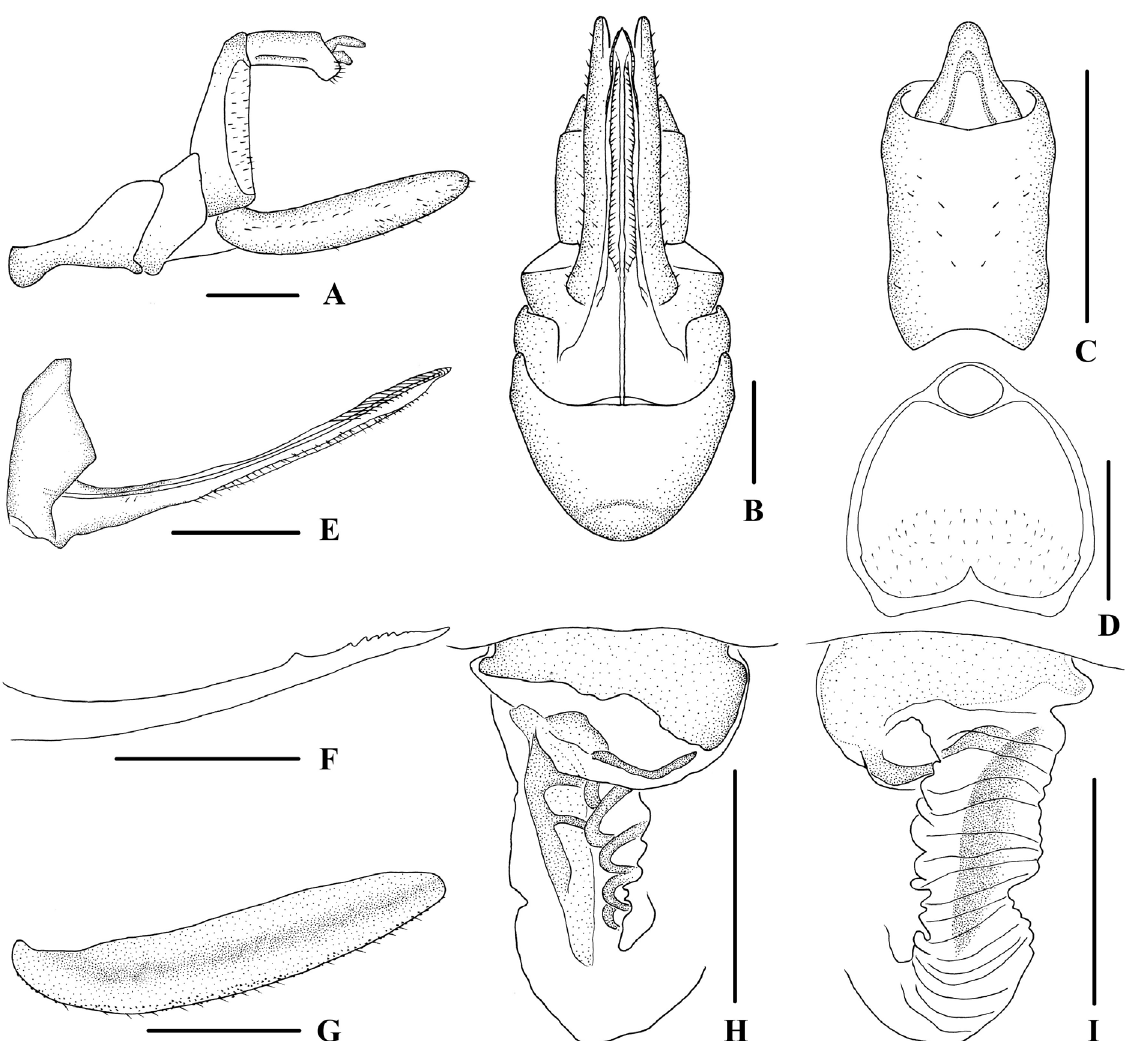
Fig. 4. Andes bifidus Wang, Zhi & Chen sp. nov., ♀. A . Genitalia, lateral view. B . Genitalia, ventral view. C . Anal segment, dorsal view. D . Tergite IX, caudal view. E . Gonapophysis VIII and gonocoxa VIII, dorsal view. F . Gonapophysis IX, lateral view. G . Gonoplac, inner lateral view. H . Posterior vagina, ventral view. I . Posterior vagina, dorsal view. Scale bars: 0.5 (Fig. 4G) rod-like, 4.7 × as long as wide in lateral view. Posterior vagina pattern as shown in Fig. 4H–I. Distribution China (Yunnan).